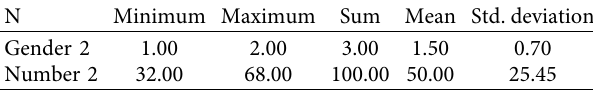
Table 1: Descriptive statistics of male and female ratio. N Minimum Maximum Sum Mean Std.